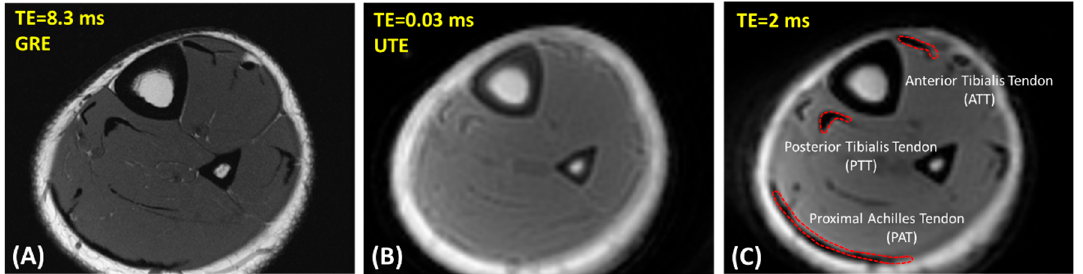
Figure 1. Representative axial images of the lower leg of a healthy 25-year-old female participant using ( A ) clinical gradient echo (GRE) sequence (TR = 790 ms, TE = 8.3 ms, in ‐ plane matrix = 352 × 352), ( B ) ultrashort echo time (UTE) Cones MRI sequence (TR = 80 ms, TE = 0.032 ms, in ‐ plane matrix = 160 × 160), and ( C ) Cones MRI sequence at TE = 2 ms (TR = 80 ms, in ‐ plane matrix = 160 × 160). Representative regions of interest (ROIs) for anterior and posterior tibialis (ATT and PTT) tendons and proximal Achilles (PAT) tendons were selected at TE = 2 ms because it provided higher contrast (indicated by red dashed boundary).